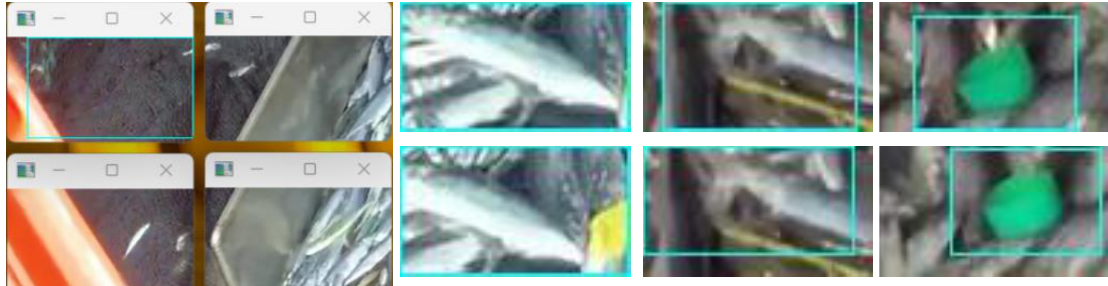
Figure 8. Prediction results and details for the second quadrant image.